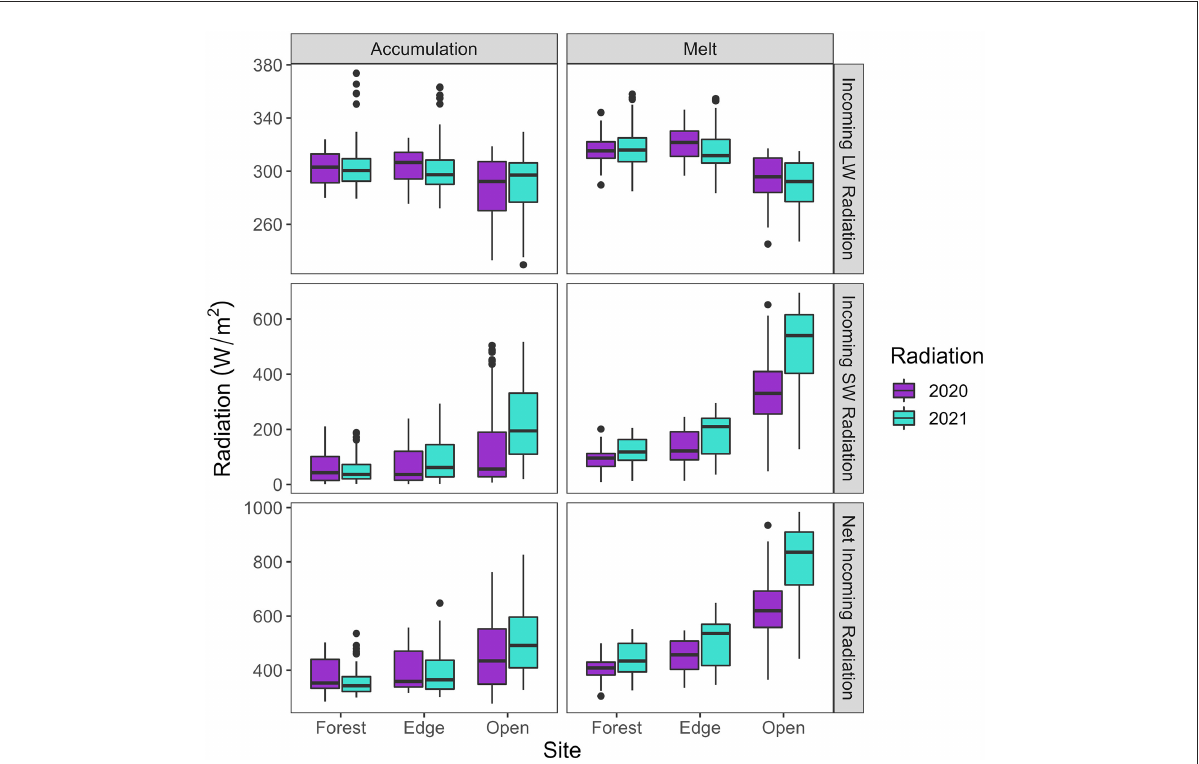
FIGURE6 Daily average longwave radiation, incoming shortwave and net incoming radiation for WY 2020 and WY 2021 in the forest, open and edge sites during the accumulation and melt periods at the LDP study location. Daily values were split over the accumulation period from December-February and during the melt period from March—snow